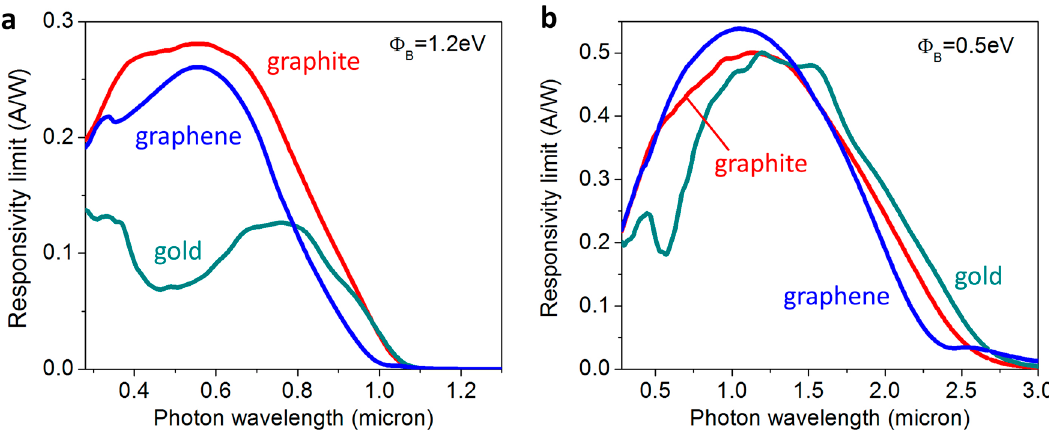
Figure 4. Responsivity limits for the IPE photo-detectors with gold (teal), graphene (blue), and graphite (red) as the absorber materials as a function of the photon wavelength for two potential barrier heights, Φ (cid:3003) = 1.2 eV ( a ) and Φ (cid:3003) = 0.5 eV ( b ).